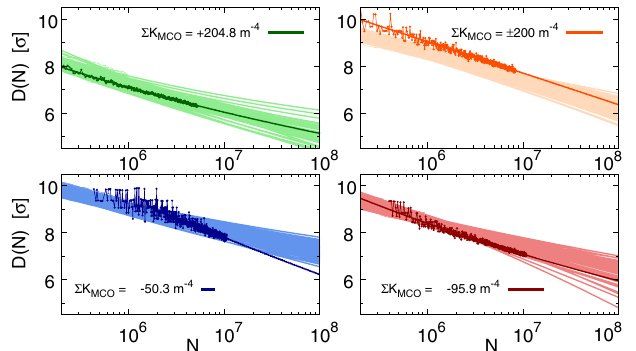
FIG. 8. Summary of the measured and simulated DA values FIG. 7. Comparison between measured DA (lines with full corresponding to D ð 1 × 10 6 Þ , plotted for the various configura- markers) and extrapolation (lines) of the numerical estimate tions of the MCO strength. The error bars of measurement results based on the scaling law (2) for four selected cases. The very are obtained by the spread of DA values for 10 6 turns (see the good agreement is clearly visible. The upper right plot refers to experimental curves in Fig. 6). The error bars of simulation the case with alternating signs for the strength of the MCOs. The results are obtained from the DA distribution over the sixty DA is not given in units of beam σ , but rather in units of the realizations of the LHC lattice (both rms and min/max error bars nominal σ obtained with the nominal beam emittance of are shown). The DA is not given in units of beam σ , but rather in ϵ ¼ 3 . 75 μ n units of the nominal σ obtained with the nominal beam emittance ¼ 3 . 75 μ m. of ϵ n realizations. Some difference in the slope of D ð N Þ is visible ¼ − 50 . 3 m − 4 . Figure 7 only for the case with Σ K MCO shows the comparison between the measured DA and the extrapolation of the results of numerical simulations based on the scaling law (2). The results of numerical simulations have been fitted using the scaling law (1) using the data for N ≤ 10 5 and the fitted functions for the sixty realizations